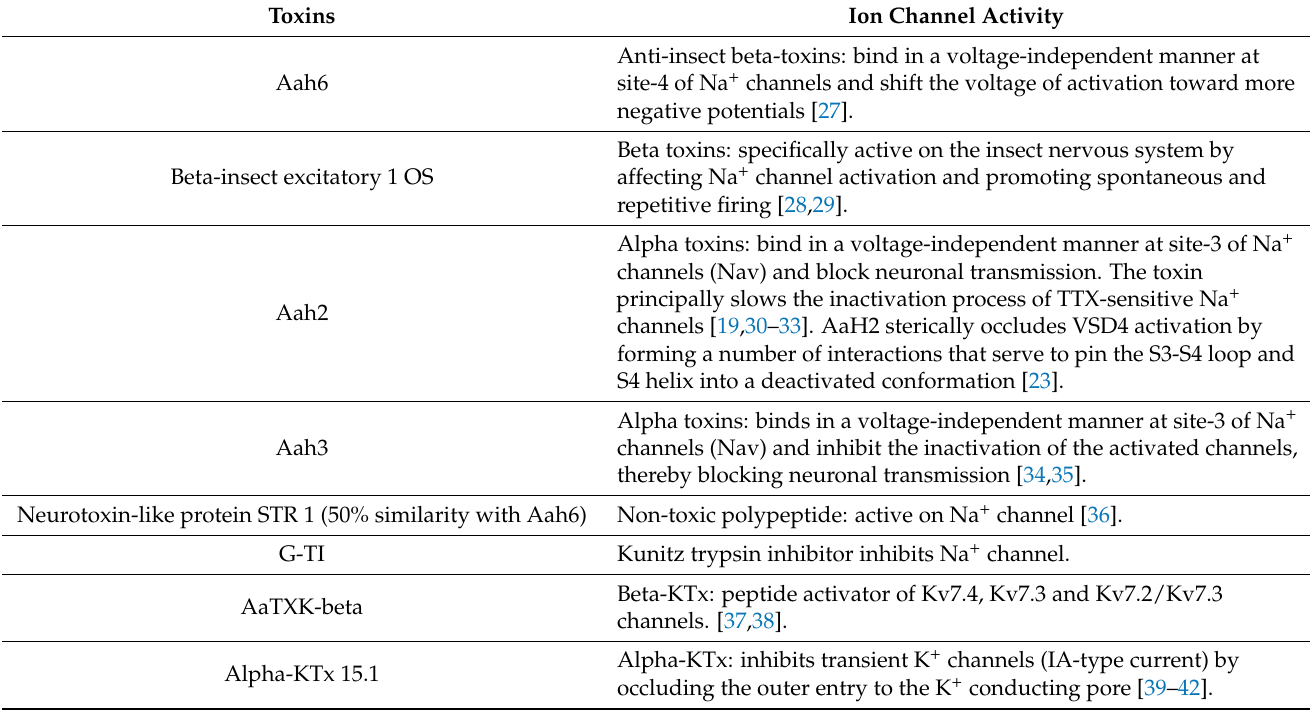
Table 2. Classification of the peptides contained in H7 according to their activities.